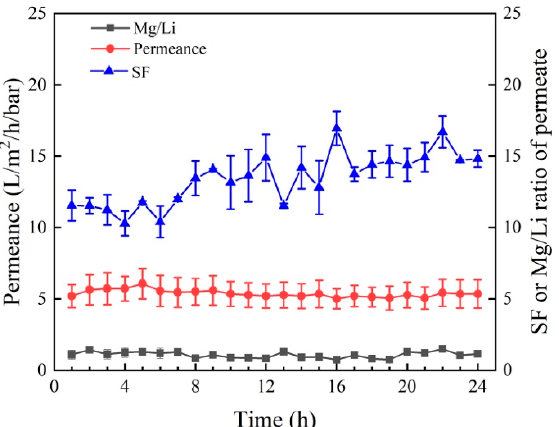
Figure 12. Long-time separation test (permeance, SF and Mg 2+ /Li + ratio of permeate) of M5 mem- brane for salt lake brine obtained from CITIC Guoan. Table 4. Comparison of separation performance of NF membranes in the literature and this work.